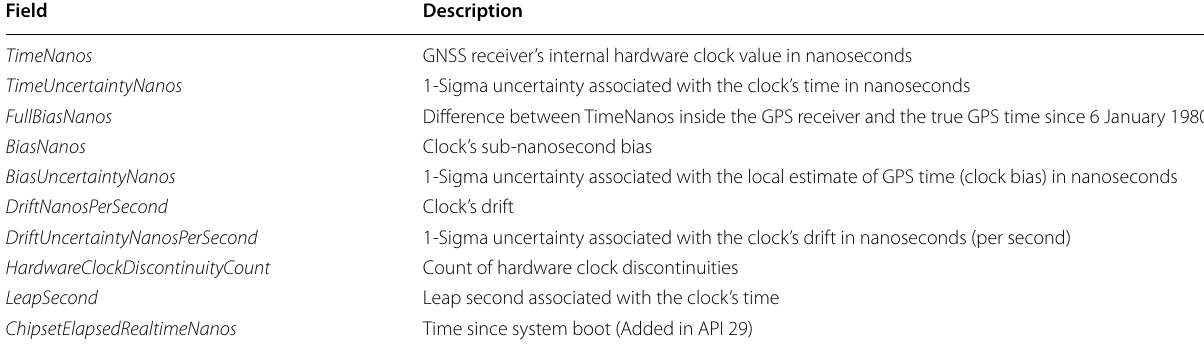
Table 1 List of variables from GNSSClock class within the Android API package “location” (European GSA, 2018b) Field Description